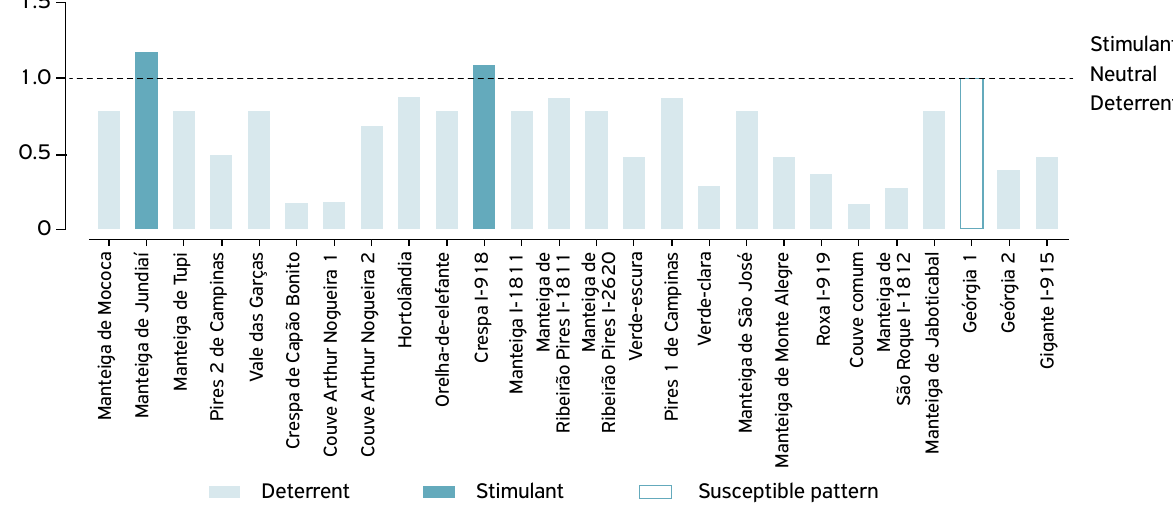
Figure 3. Feeding preference index of Ascia monuste orseis (Lepidoptera: Pieridae) in collard greens genotypes in free-choice test (temperature 25 ± 2ºC, relative humidity 70 ± 10% and photoperiod 12:12 light/darkness).